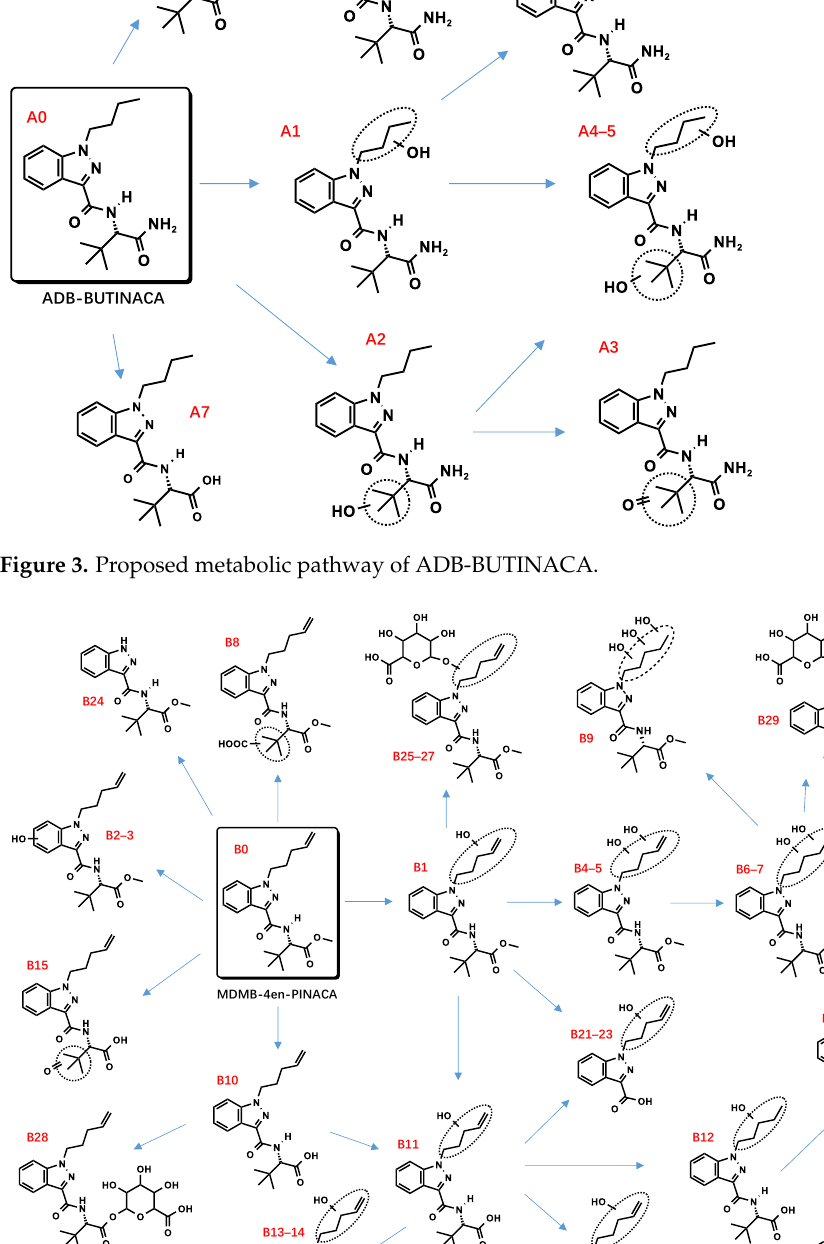
Figure 4. Proposed metabolic pathway of MDMB-4en-PINACA.